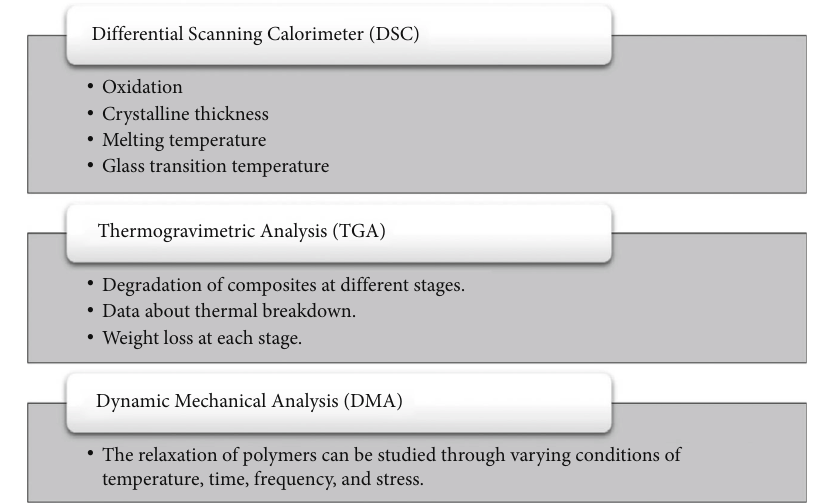
Figure 7: Major methods of thermal analysis [77 – Table 6: Temperature parameters of bamboo – reinforced polymer composites.